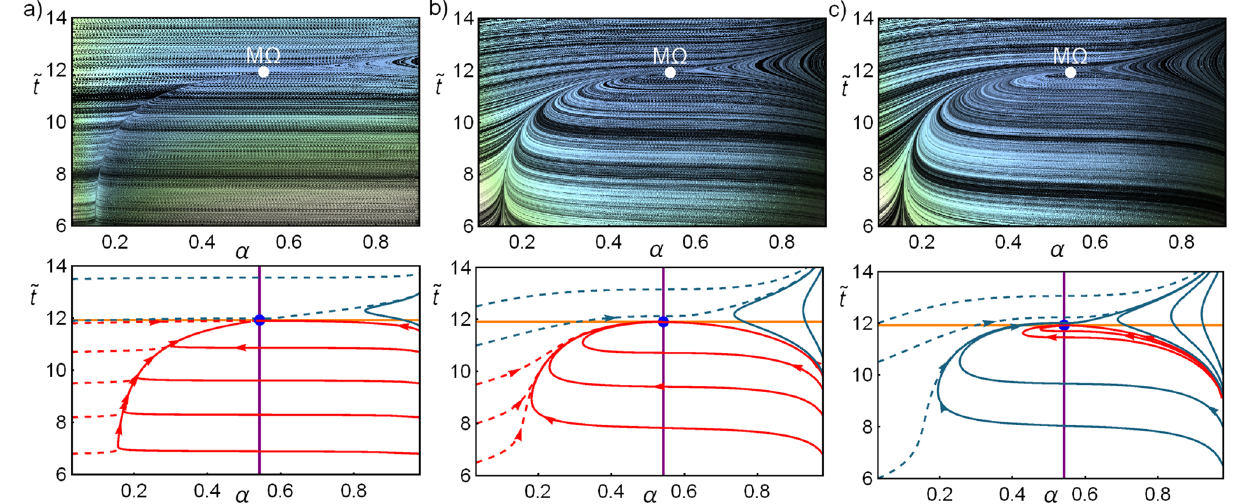
C , in ( c ) 1 , in ( b ) D = =